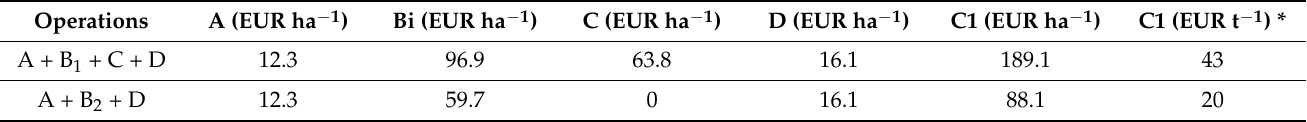
Table 6. Step I costs (EUR ha − 1 and EUR t − 1